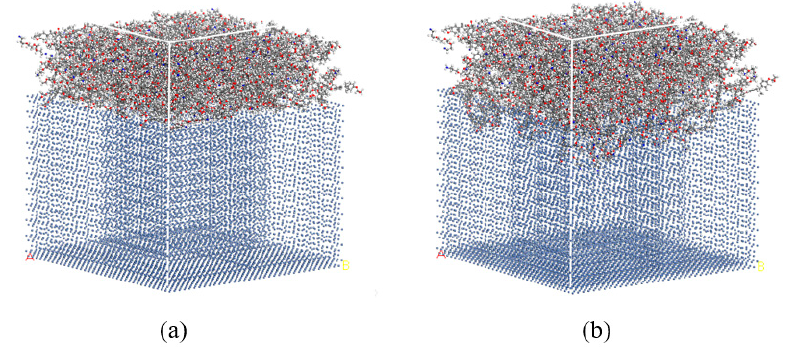
Figure 7. ( a ) The initial and ( b ) the relaxed bonding model.